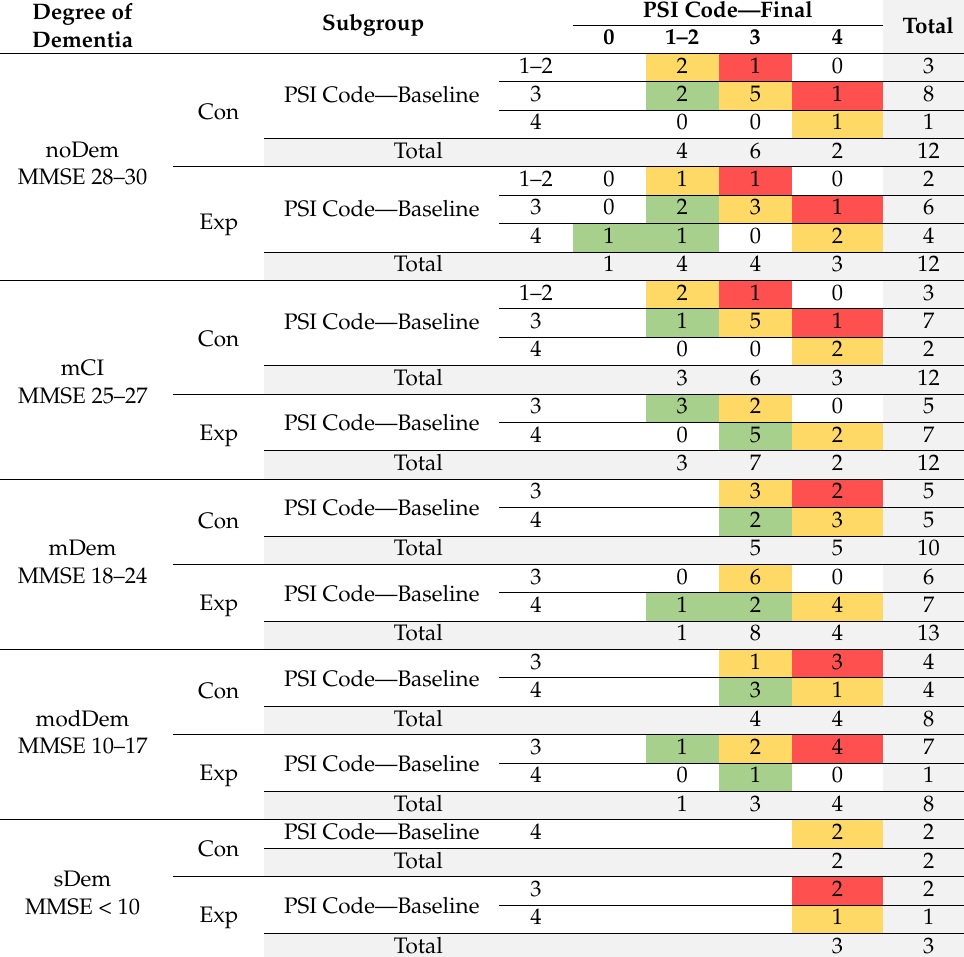
Table 3. Changes in the periodontal screening index (PSI—code 0: healthy; code 1/2: gingivi- tis/calculus present; code 3: moderate periodontitis; code 4: severe periodontitis) separated by mini mental state examination group (MMSE group) and subgroup (control and experimental group) at baseline and changes in PSI over time by MMSE group and subgroup (Con: control group; Exp: experimental group) (color coding—red: deterioration; orange: no change; green: improvement) (MMSE groups—noDem: no dementia; mCI: mild cognitive impairment; mDem: mild dementia; modDem: moderate dementia; sDem: severe